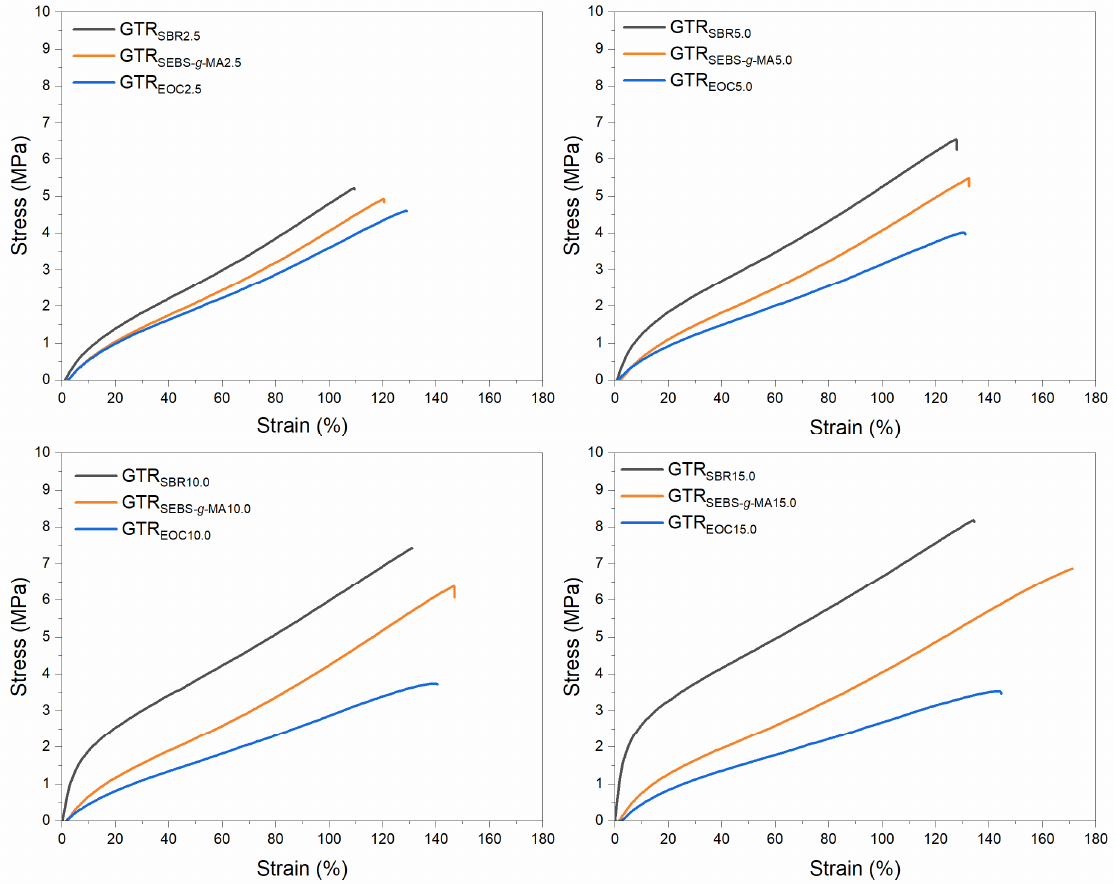
Figure 4. Stress–strain curves determined for modified GTR.